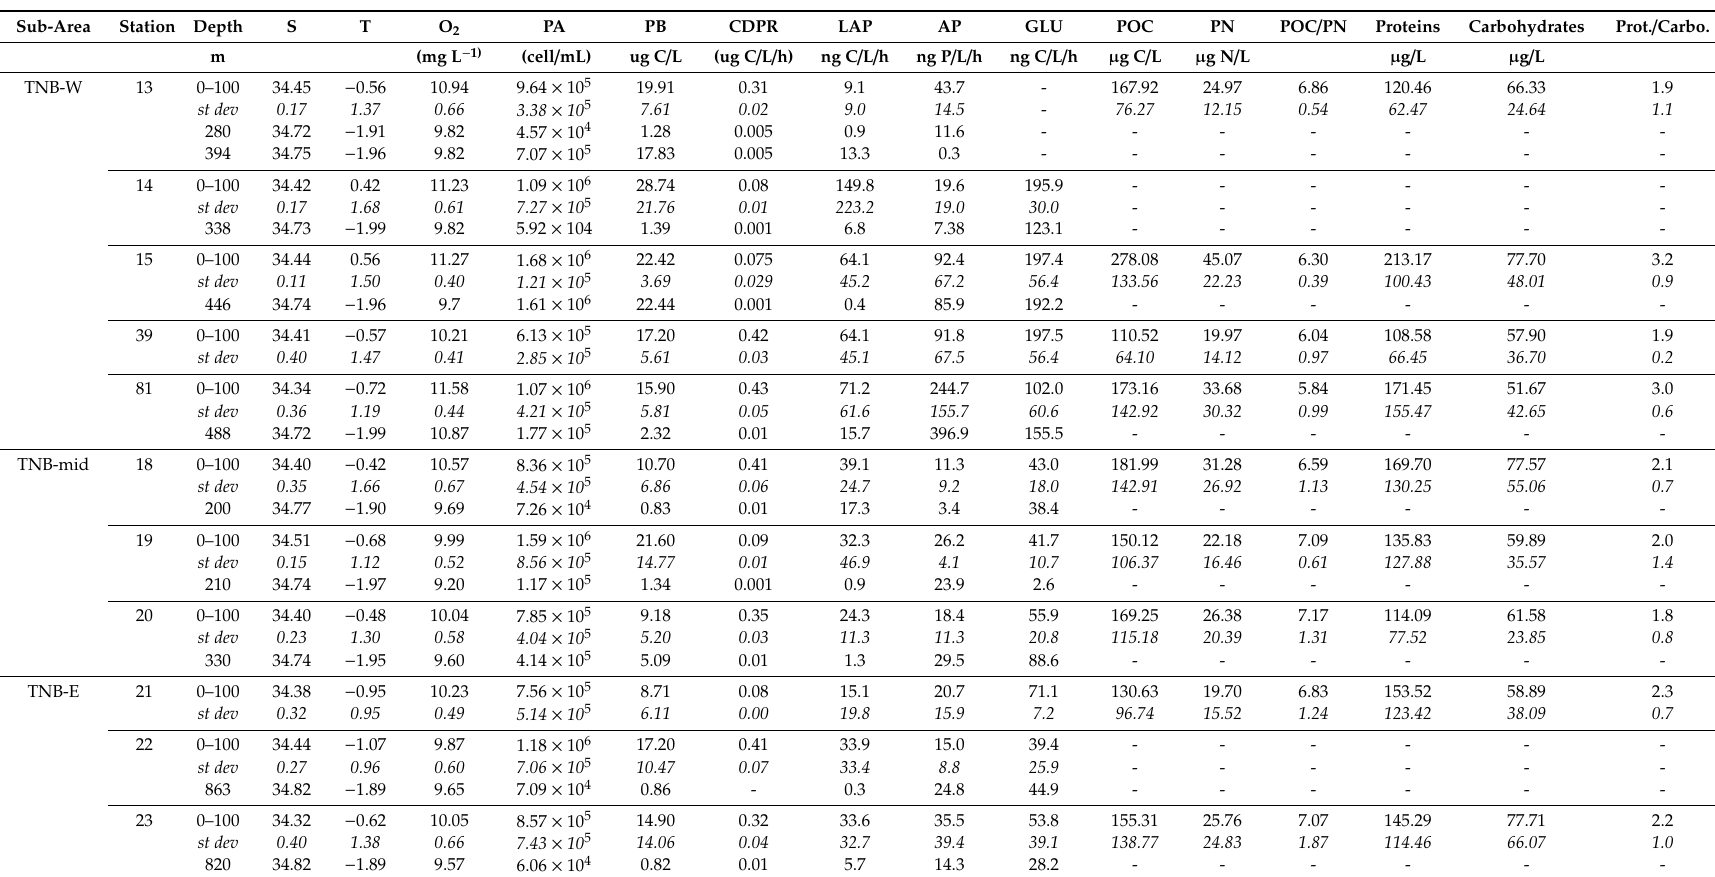
Table A1. Mean values and standard deviation for the 0–100 m for all the data and values of the variables sampled below the 100 m